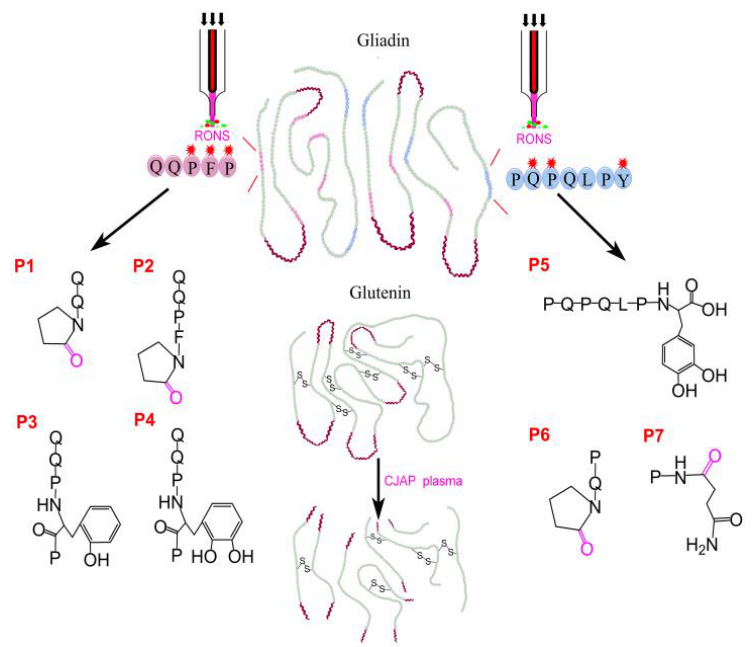
Figure 12. Schematic mechanism for wheat storage proteins and model celiac-toxic peptides modified by CJAP plasma.